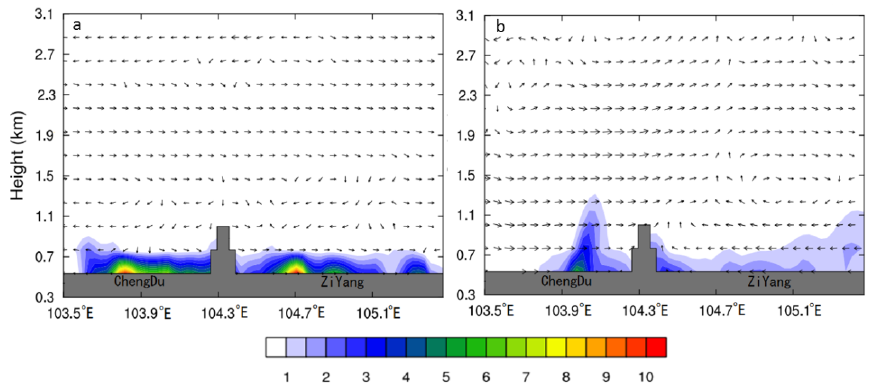
Figure 12. Vertical profile of the volume fraction of pollutants (10 − 4 ) and wind (m · s − 1 ) (along line AB in Figure 6b): ( a ) 0000 UTC on 7 May and ( b ) 1800 UTC on 7 May. Note: the gray shaded area signifies the topography.